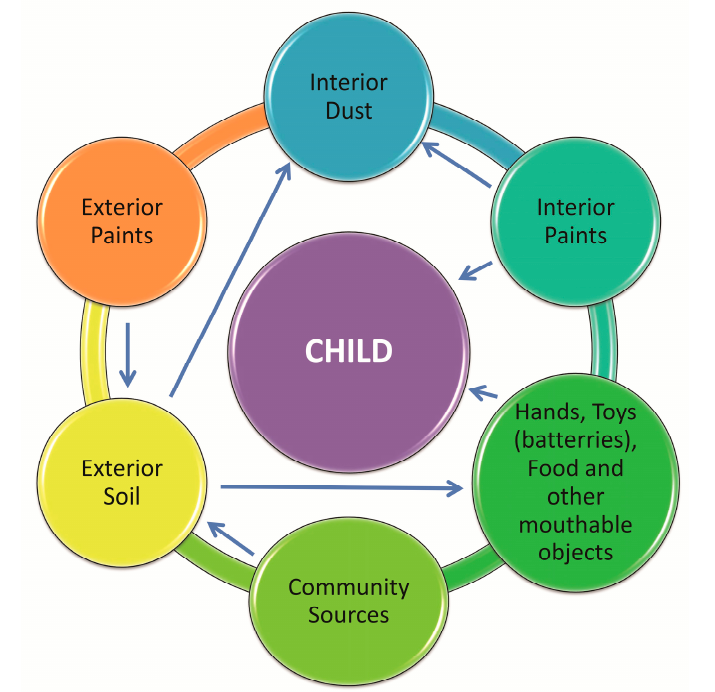
Figure 3. Possible sources of lead poisoning among children in the home environment (Adopted from: